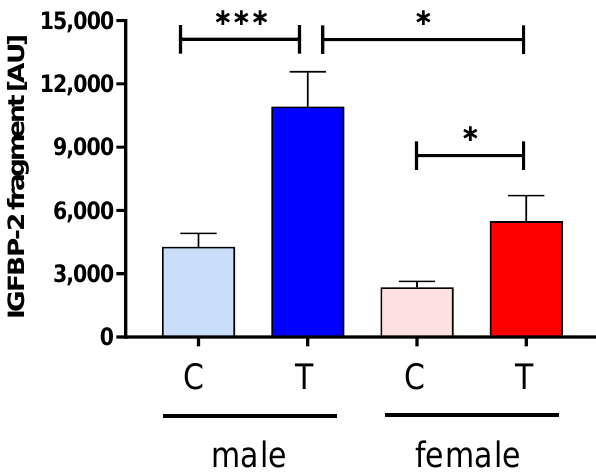
Figure 7. Relative quantification of IGFBP-2 fragments in serum from male (blue) and female (red) IGFBP-2 transgenic mice (T) and non-transgenic (C) littermates (DU6P / C57BL / 6). Analysis was performed by Western immunoblotting as described in Section 2 (mean ± SEM; age 7 weeks; n > 7; *: p < 0.05; ***: p < 0.001).